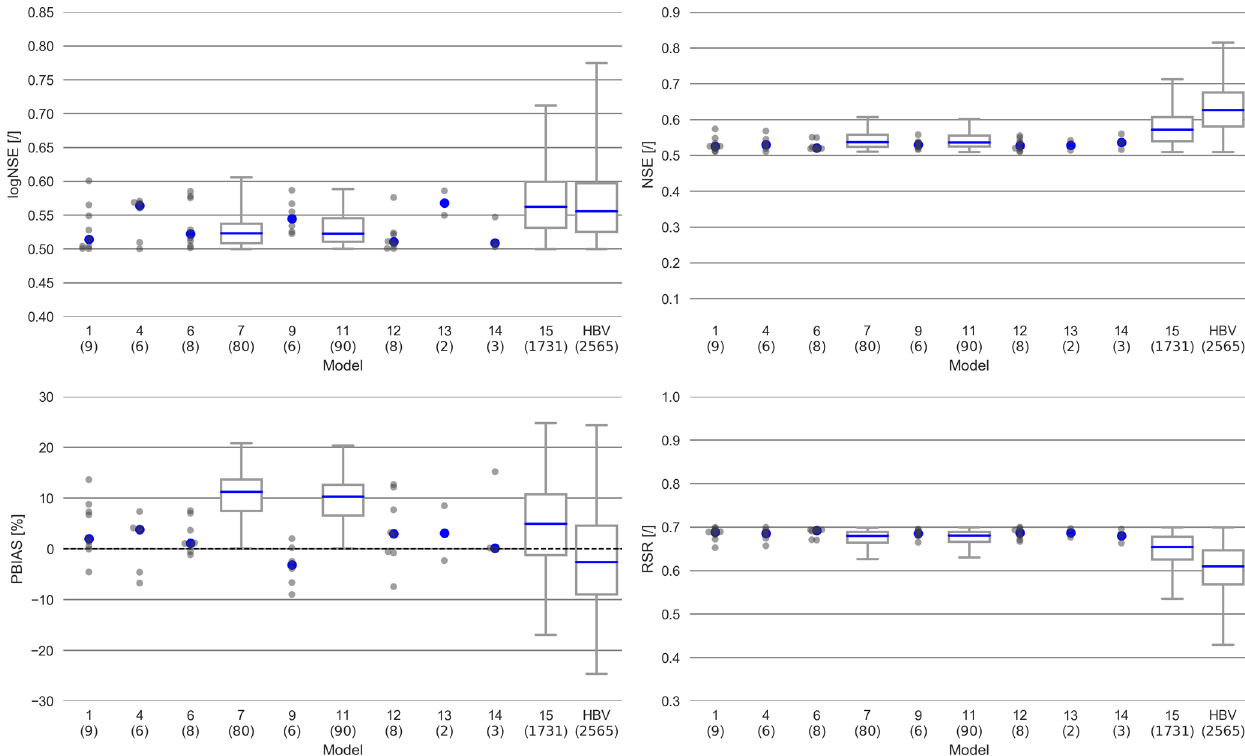
Figure 5. Distribution of the values of the behavioral runs in the calibration period. Plotted as a box plot if the number of behavioral runs is above 10. Number of behavioral runs are in brackets under the name of the model. Blue dot or line marks the